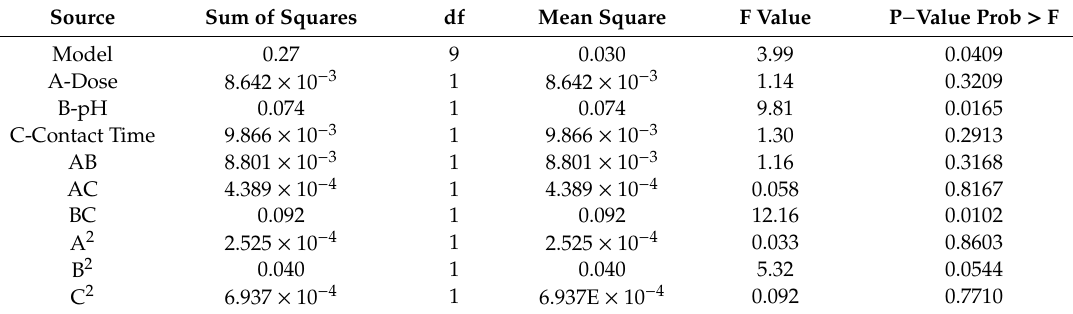
Table 4. ANOVA for Al 3 + removal of hybrid CNTs.